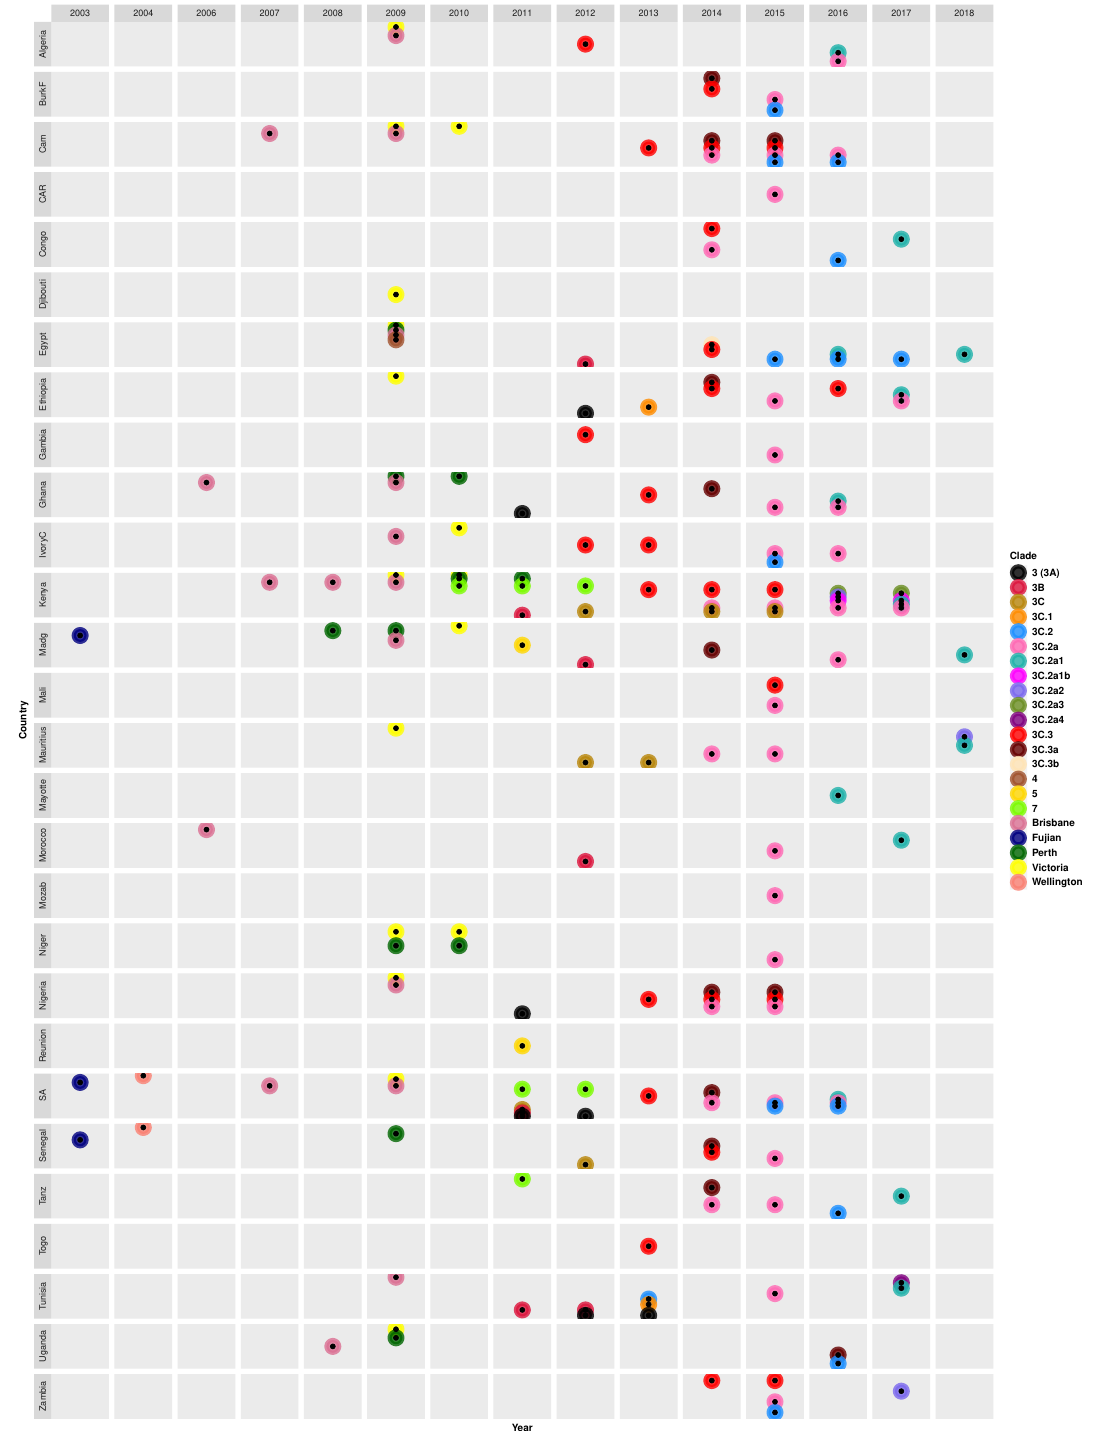
Figure 5. Temporal and geographical distribution of genetic clades of seasonal H3N2 virus strains that circulated in Africa between 2003 and 2018. Abbreviations: Burkina Faso (BurkF), Cameroon (Cam), Cape Verde (CapeV), Central African Republic (CAR), Ivory Coast (IvoryC), Madagascar (Madg), Mozambique (Mozab), South Africa (SA), Tanzania (Tanz). A/Brisbane/10/2007(H3N2)-like clade (Brisbane), A/Fujian/411/2002(H3N2)-like clade (Fujian), A/Perth/16/2009(H3N2)-like clade (Perth), A/Victoria/208/2009(H3N2-like clade (Victoria), and A/Wellington/1/2004(H3N2)-like clade (Wellington). Details on the characteristic genomic markers (amino acid substitutions in the HA1 proteins) for each clade are described in Table